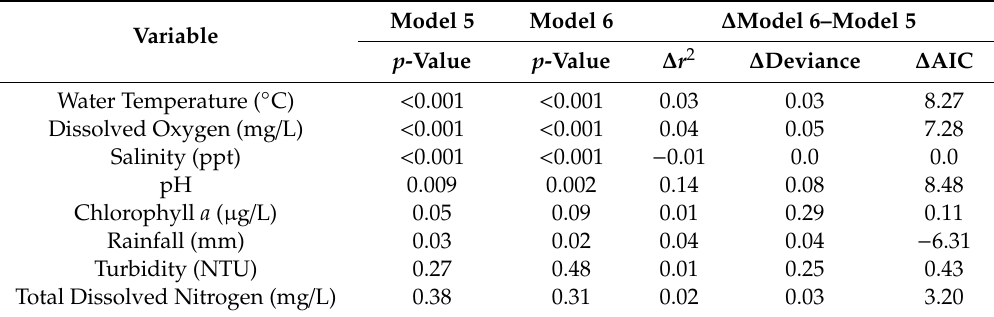
Table 3. The relationship between V. parahaemolyticus concentrations and environmental variables and fit improvement based on linear (Model 5) and non-linear (Model 6) regression models in GBE in 2007–2017. Positive values indicate that the measure improved in Model 6 compared to Model 5 and negative values indicate a decrease in the model evaluation measurement.